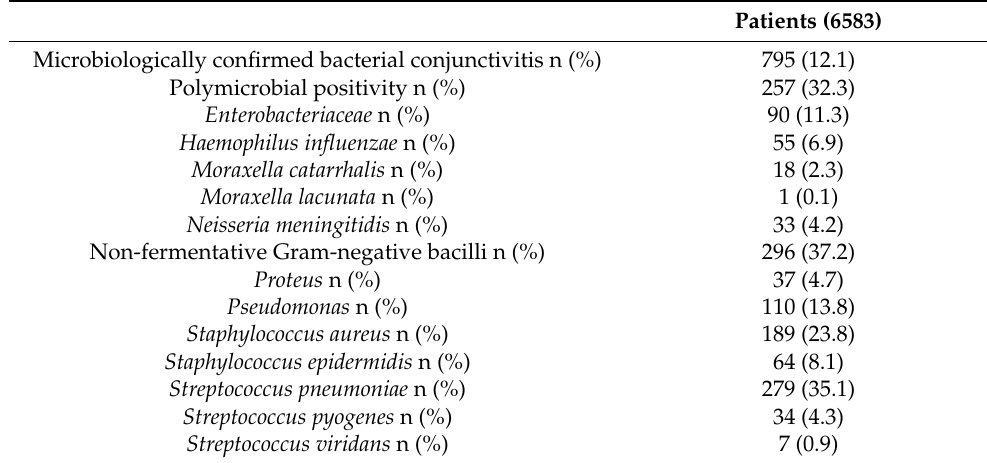
Table 2. Microbiological